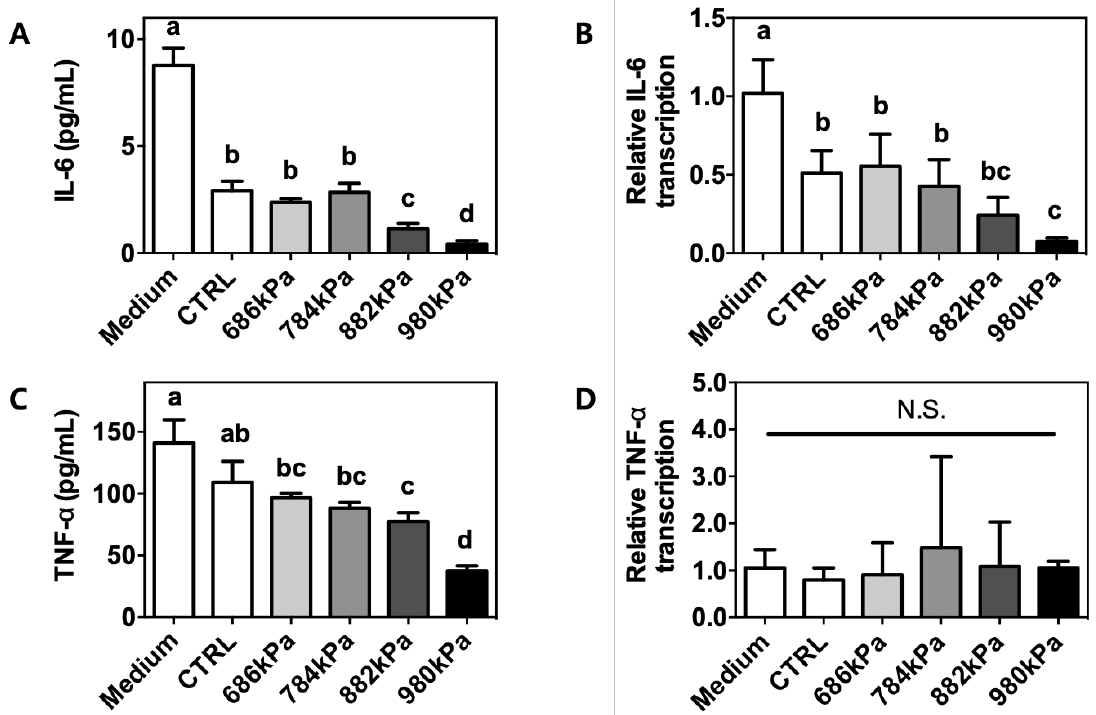
Figure 4. Reduced production of inflammatory cytokines in RAW264.7 macrophages following treatment with pu ff ed turmeric extracts. Following treatment with 500 nm / mL LPS for 12 h to induce an inflammatory response, the culture media and cell pellets were separated for quantification of secreted cytokines ( A and C ) and intracellular mRNA levels ( B and D ), respectively. Means with di ff erent letters (a–d) were statistically significant at p < 0.05 within the panel ( n =